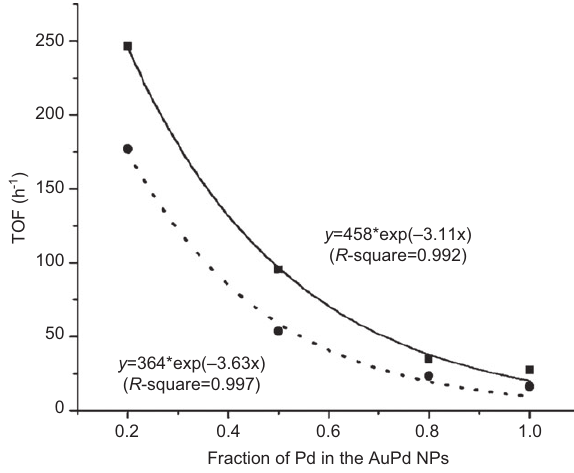
Figure 6 TOF as function of the Pd fraction in bimetallic NPs. © Wiley-VCH [55]